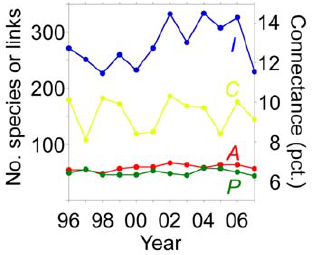
Figure 1. Temporal variation in basic butterfly–nectar plant network characteristcs. Numbers of butterfly species ( A ), plant species ( P ), links ( I ), and connectance ( C ) during 12 years of study.